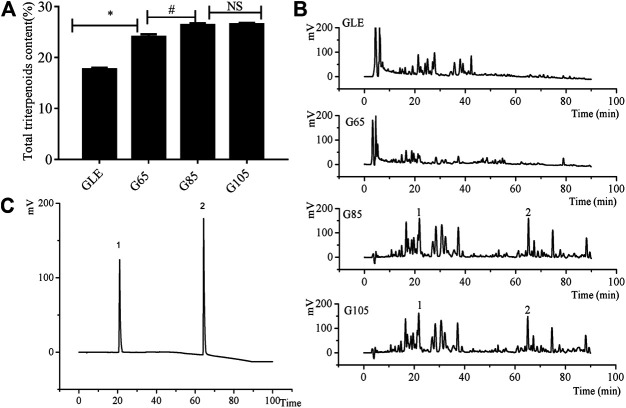
The chemical analysis of the extracts. (A) The total triterpenes content of G
. lucidum extracts (B) HPLC chromatograms of G
. lucidum extracts (C) HPLC chromatograms of reference substance. 1) ganoderic acid A, 2) ganodermanontriol. Data were shown as mean ± SD (n = 3), *p < 0.05 vs GLE, #
p < 0.05 vs G65, NS means no significant difference.